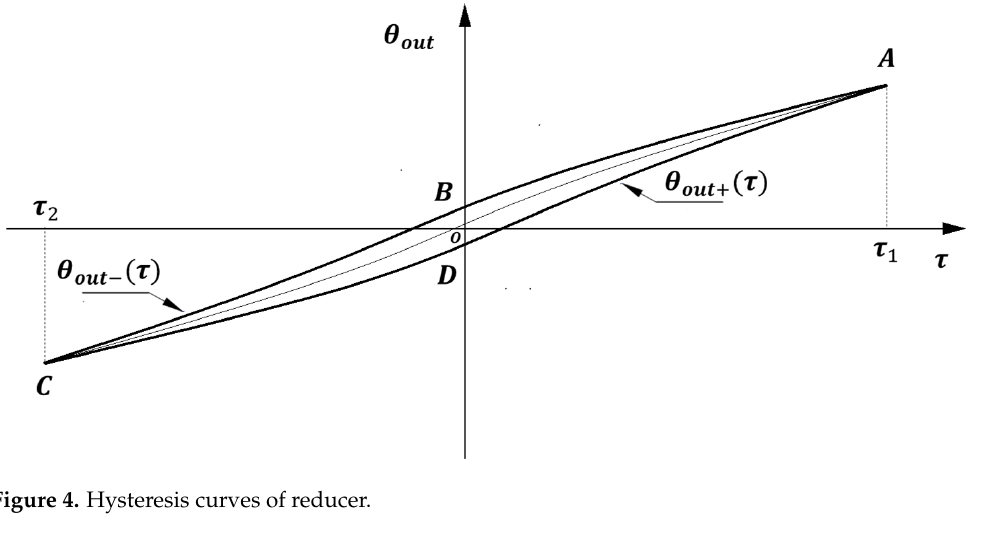
Figure 4. Hysteresis curves of reducer.